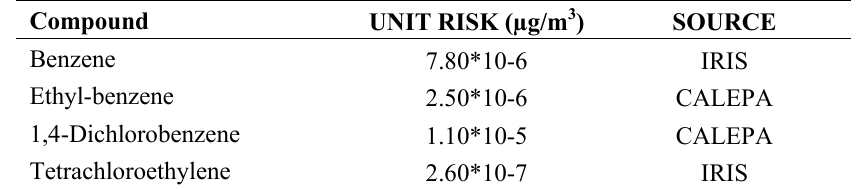
Table 2. Cancer unit risks of the VOCs found during the monitoring